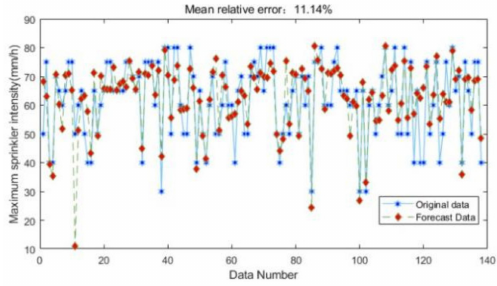
Figure 9. The smoothness parameter of the RBF neural network is 1.13.